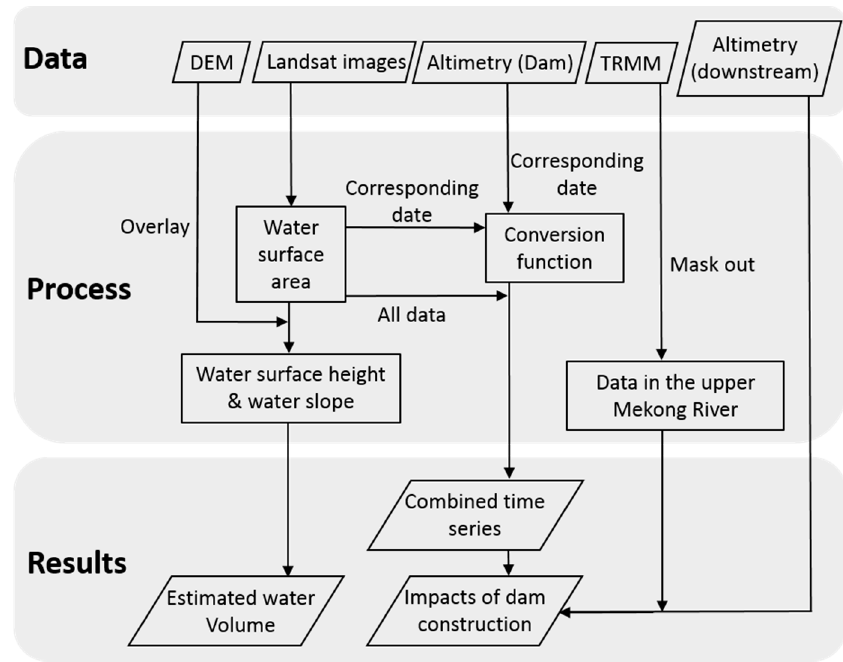
Figure 4. Flowchart of the methodology developed in this study.